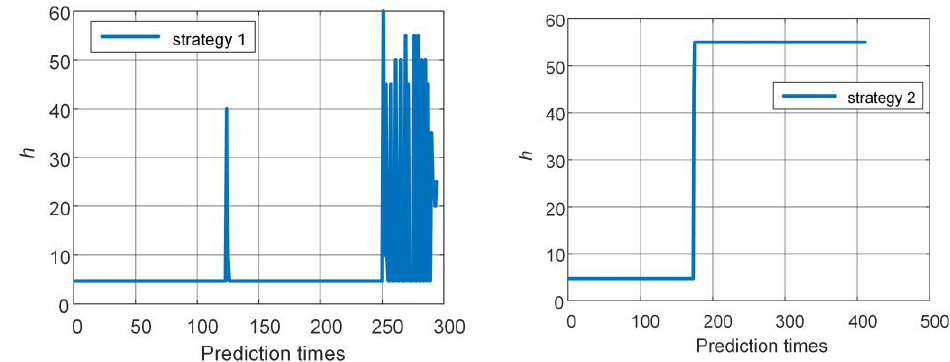
Figure 17. h comparison under constant 165W power